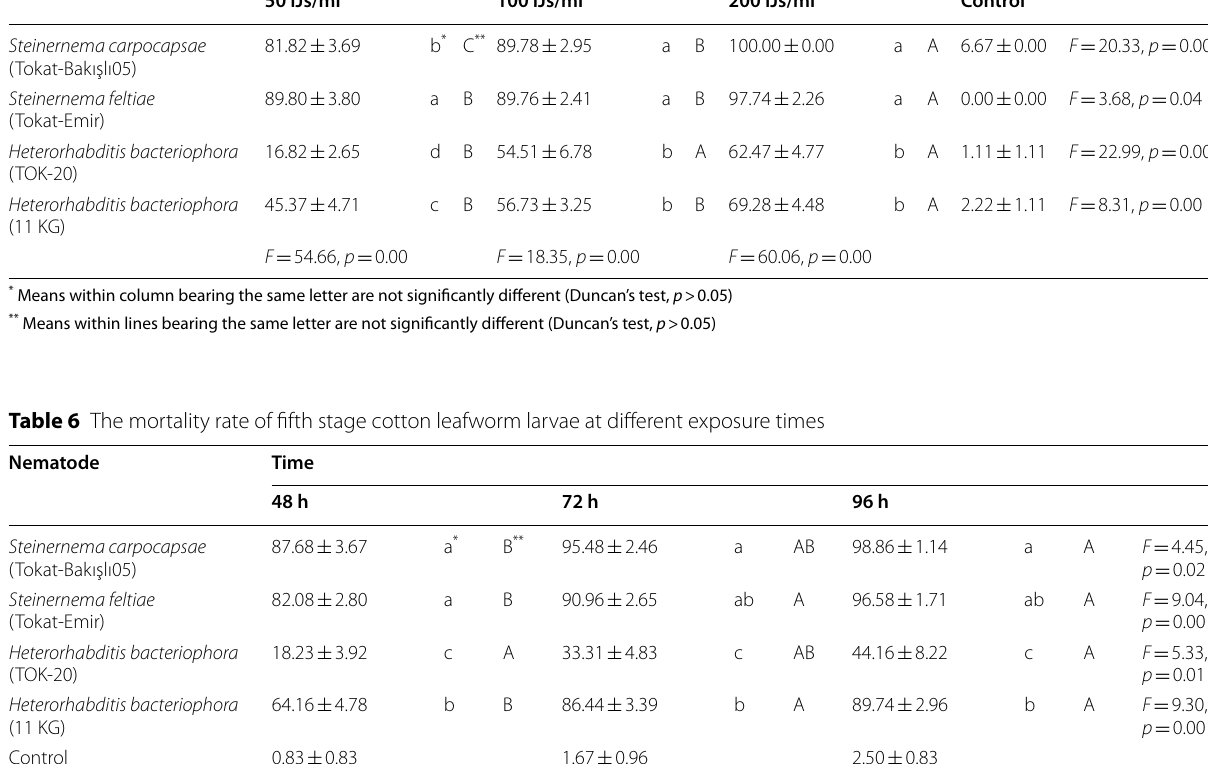
* Means within column bearing the same letter are not significantly different (Duncan’s test, p > 0.05) ** Means within lines bearing the same letter are not significantly different (Duncan’s test, p >